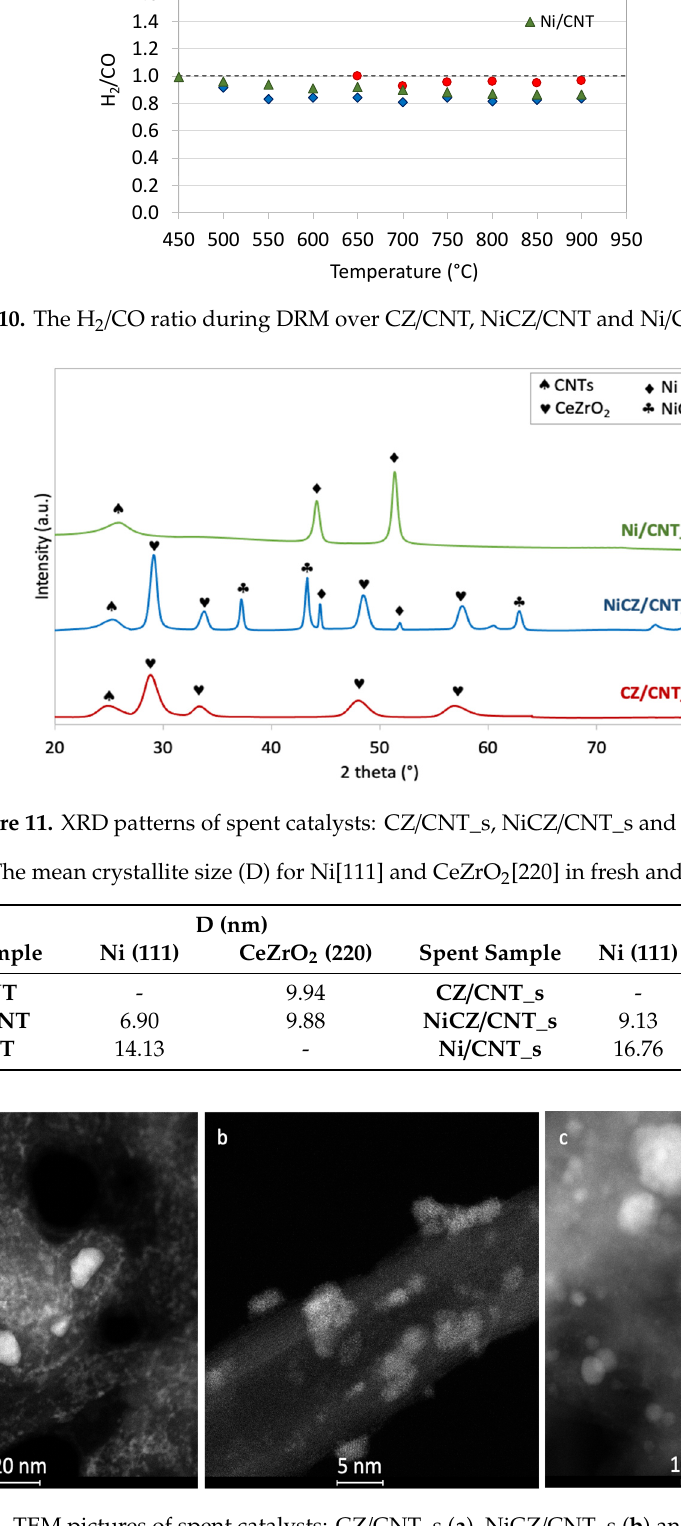
Figure 12. TEM pictures of spent catalysts: CZ/CNT_s ( a ), NiCZ/CNT_s ( b ) and Ni/CNT_s ( c ).